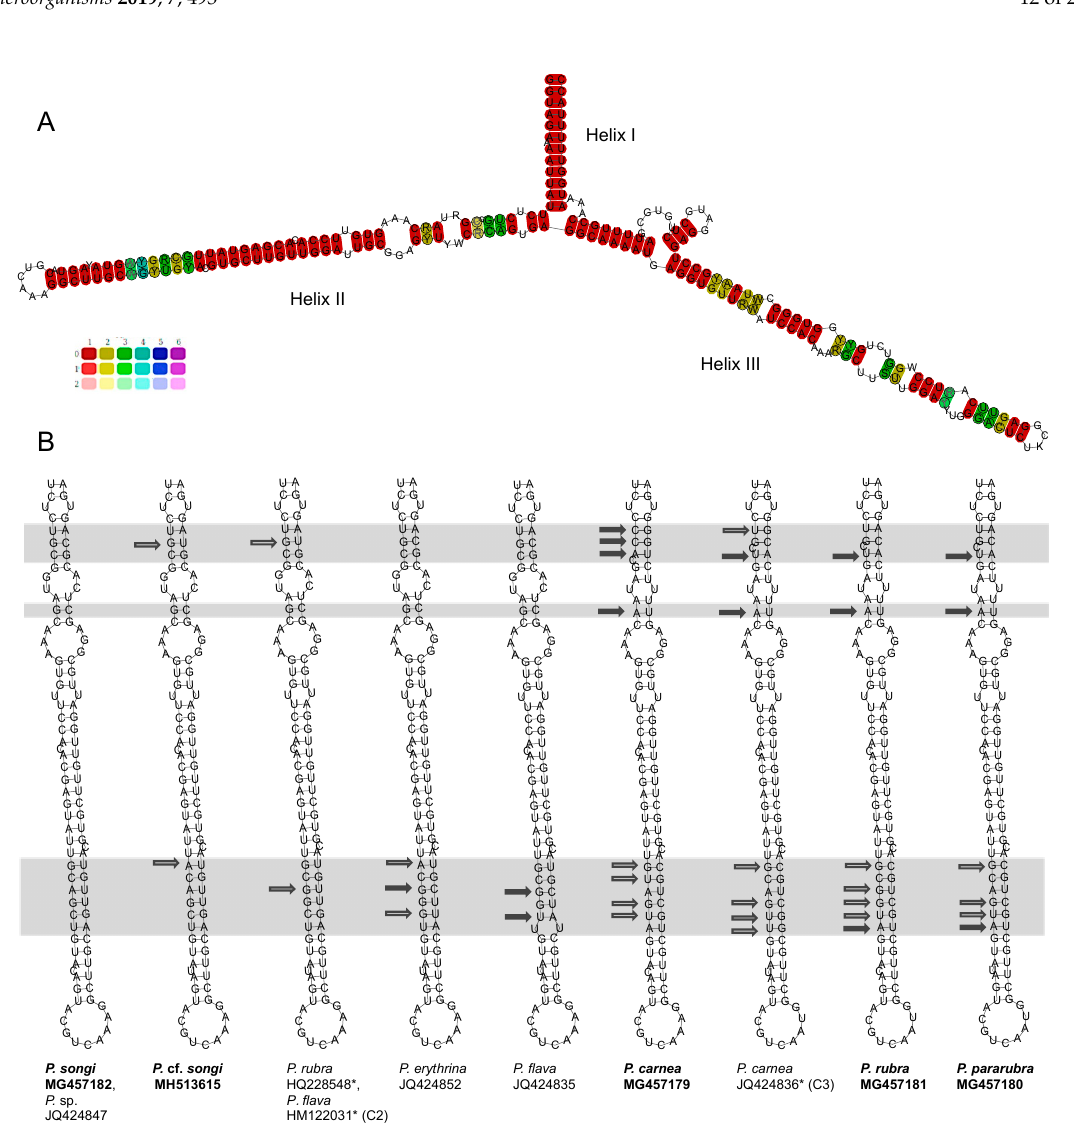
Figure 5. Secondary structure features of the Pseudokeronopsis LSU-D2 molecule. ( A ) Consensus secondary structure predicted using the LocARNA Sever. Color bars (0–1) indicate base-pairing probability. ( B ) Helix II structures of congeners. Using the structure of P. songi as a reference, CBCs are marked with filled arrows and hemi-CBCs are indicated with hollow arrows. The variable regions are marked by grey boxes. Newly sequenced species are in bold. *, misidentified species.